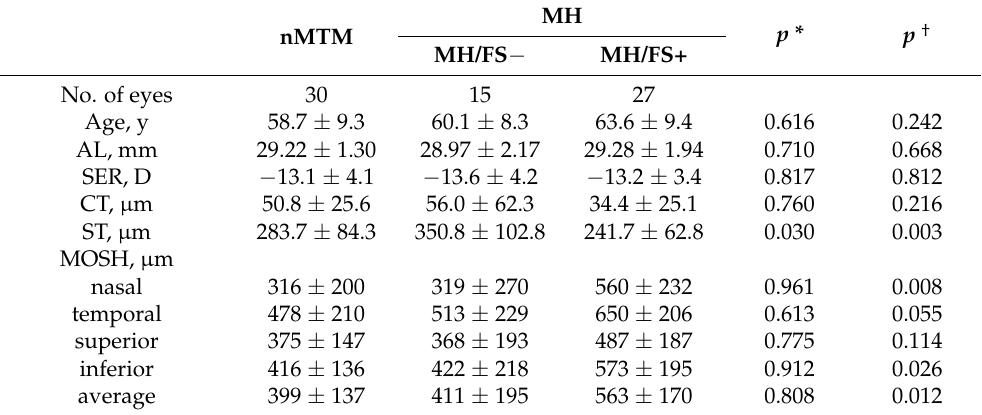
Table 3. Comparisons among the nMTM group and the MH/FS − and MH/FS+ subgroups in highly myopic